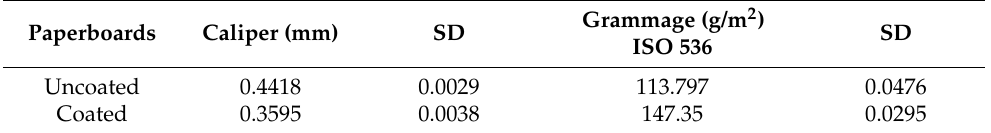
Table 2. Caliper and grammage of